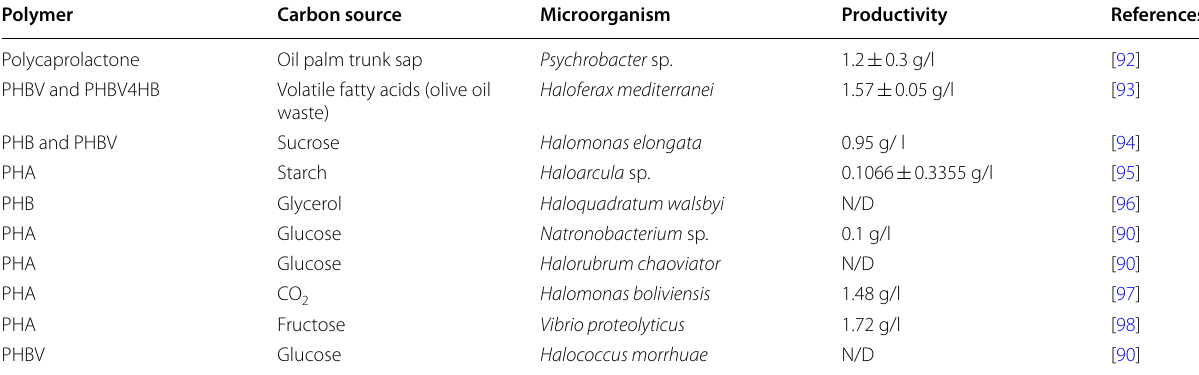
Where N/D indicates not determined